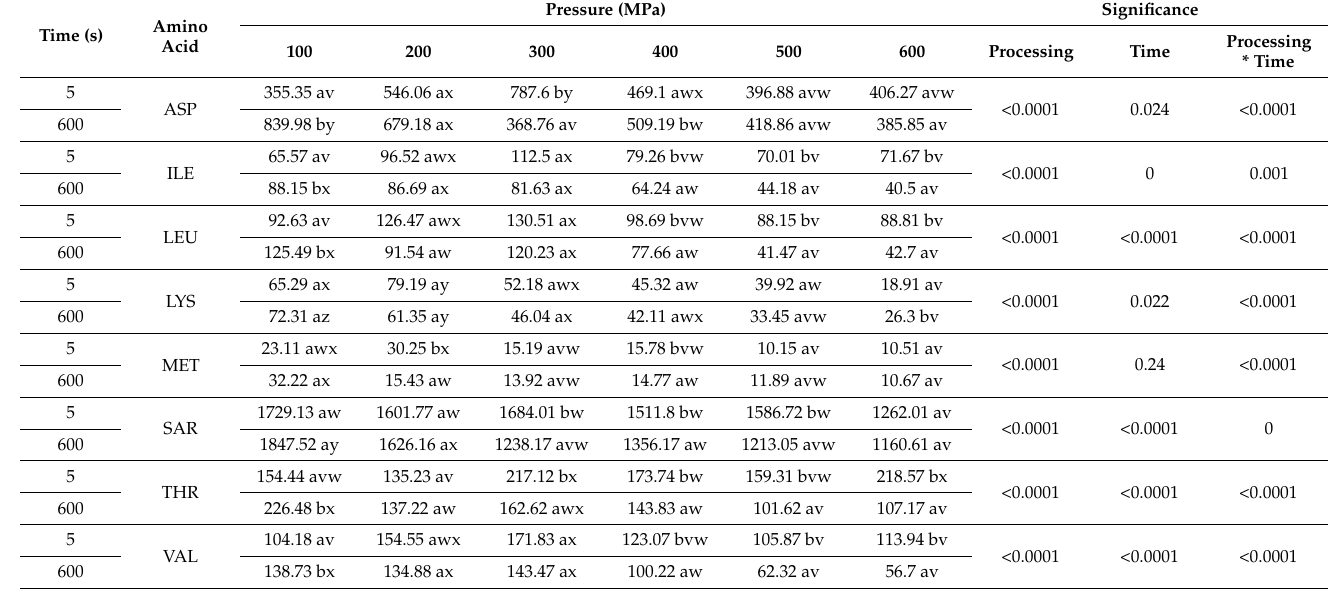
Table 3. Free amino acid composition of Storm Shell ( Mactra murchisoni ) clam. a,b means with different letters within a row show the significant effect of time at each processing pressure; v,w,x,y,z means with different letters within column show the significant effect of time under the same processing pressure. * Compounds identified with VID coefficients higher than 0.8.